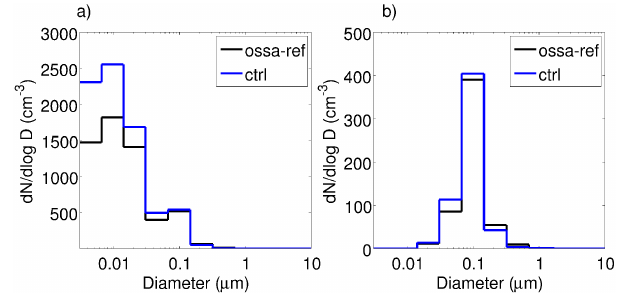
Figure 15. Five-year mean size distribution over the Southern Ocean in the five lowest model levels (about up to 1km) (a) of all aerosol particles, and (b) of particles activated to cloud droplets. The size-resolved number of activated cloud droplets was diagnosed also for cloud-free time steps and may thus differ from the distribu- tion diagnosed for only cloudy time steps. The diameter refers to dry size in both